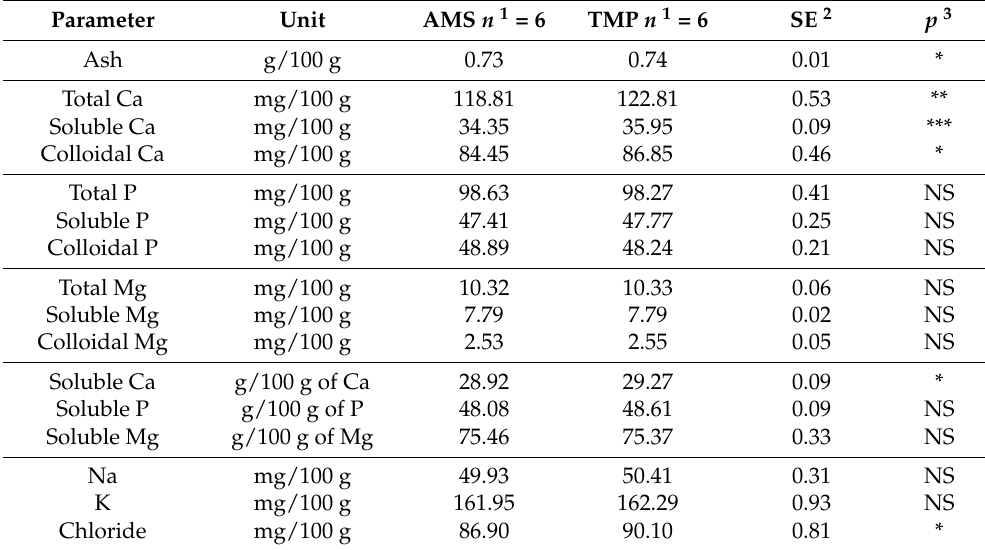
Table 3. The least square means of minerals contents and salt equilibria of herd whole milk milked with an automatic milking system (AMS) and with a traditional milking parlor (TMP).